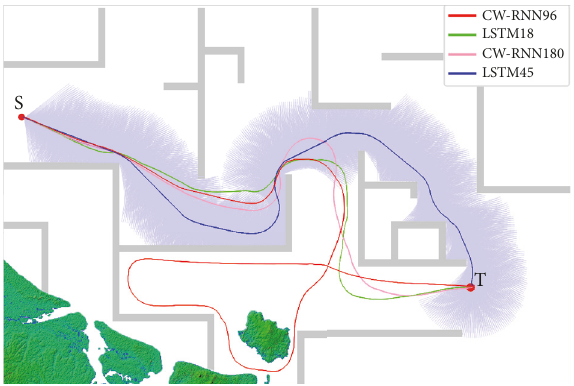
Figure 13: Online planning results of several obstacle avoidance algorithms of UUV in simulation test case 3.